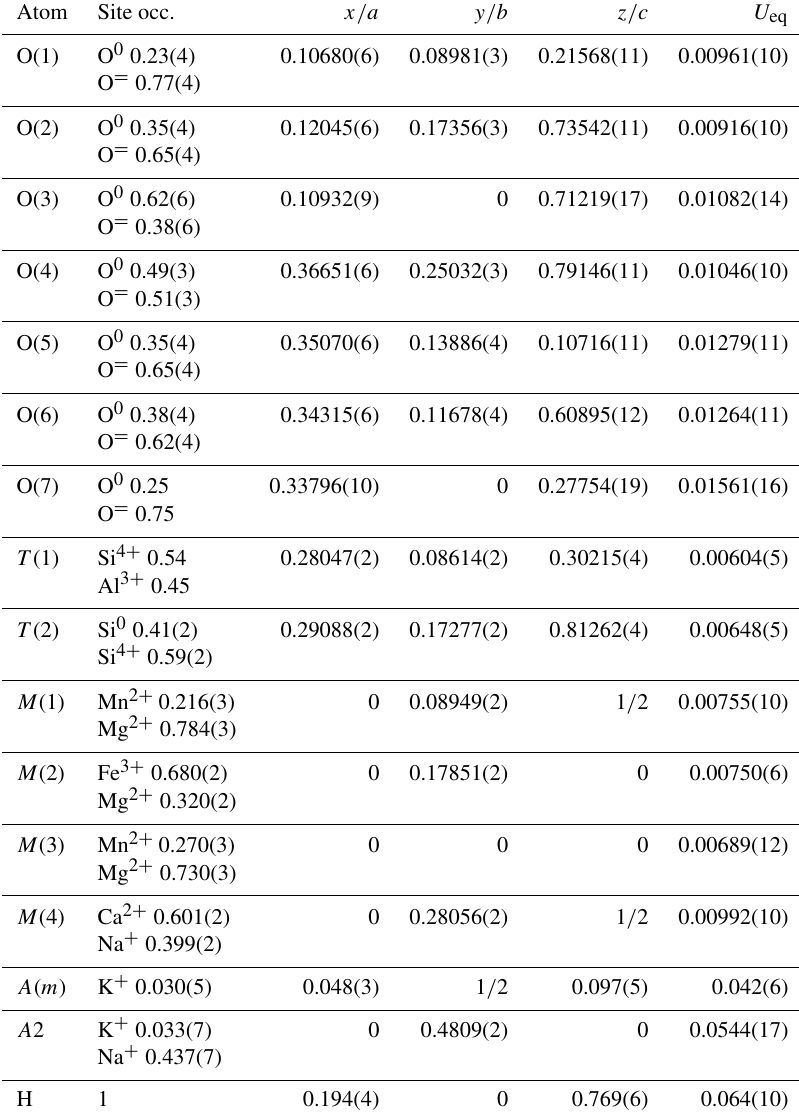
Table 5. Refined atom coordinates and equivalent isotropic displacement